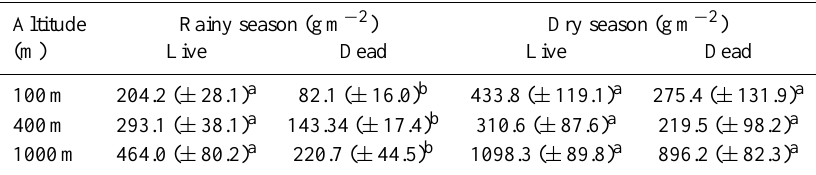
Table 2. Fine root biomass (live and dead) at different altitudes in the rainy and in the dry season. Values represent mean and standard error of four replicates per altitude.